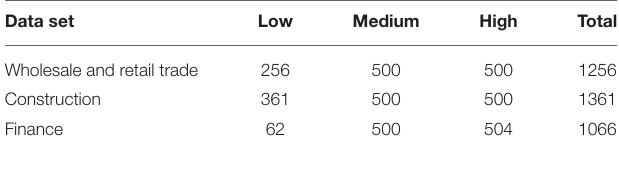
TABLE 1 | Number of enterprises of each rating class as they appear in our data sets.